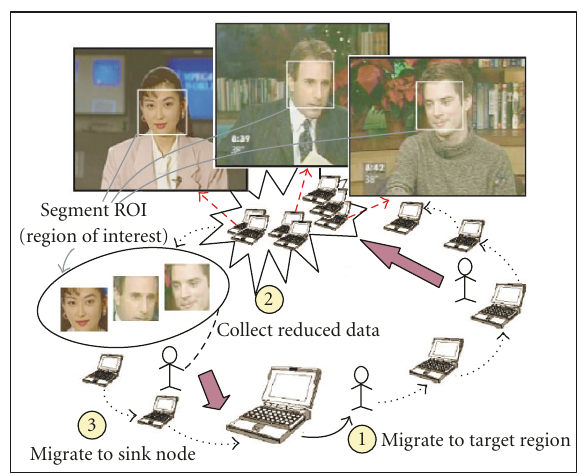
Figure 1: Mobile agent-based image sensor